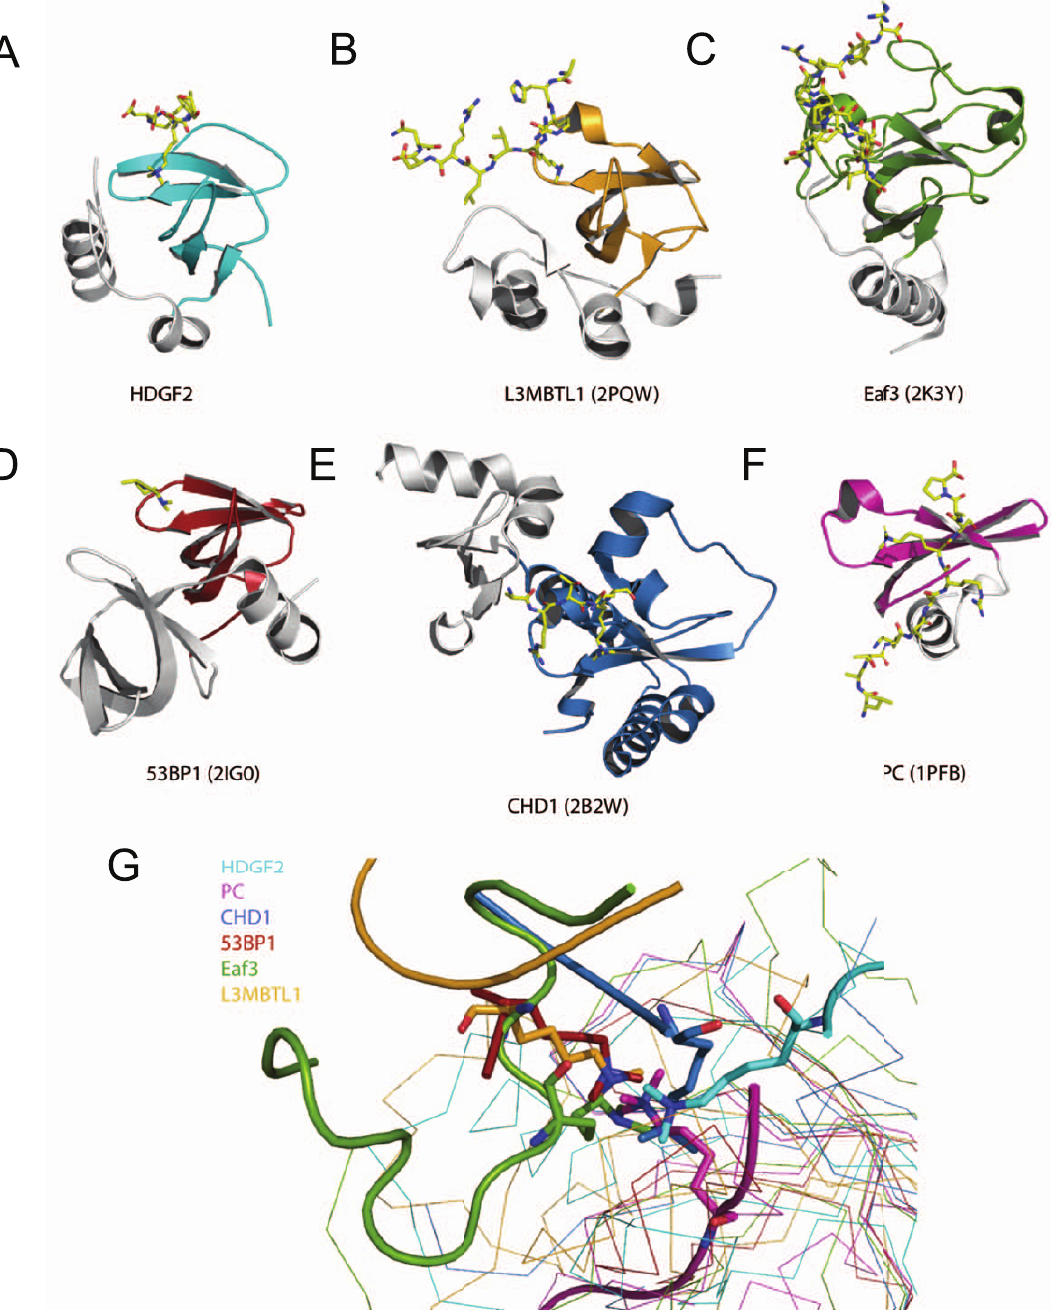
Figure 7. Comparison of the binding modes of methylated histone peptides to PWWP domain, chromo domain, Tudor domain and MBT repeat domain. (A–F) Different histone code reader domains shown individually in complex with their corresponding ligands: HDGF2- H3K36me3 (cyan, A), L3MBTL1-H4K20me2 (yellow, B), Eaf3-a mimic H3K36me2 peptide (green, C), 53BP1-H4K20me2 (red, D), CHD1-H3K4me3 (blue, E), Polycomb-H3K27me3 (magenta, F). The peptides are shown in stick models. (G) Superposition of different histone code ‘‘reader’’ domains in complex with their corresponding ligands. All the structures are shown in the same orientation as they are in Fig. 7A–7F. The conserved b -sheet core among these domains is colored the same as in Fig.